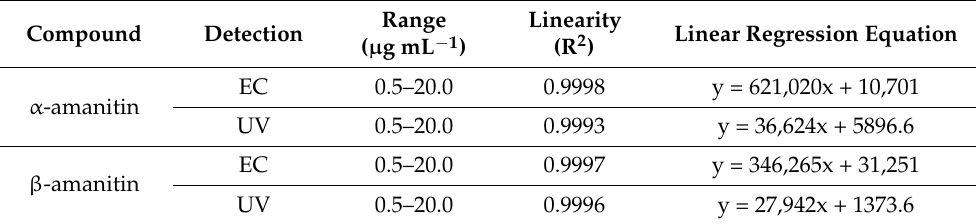
Table 1. Calibration curve parameters of α - and β -amanitin; regression equation and coefficient (R 2 ) are expressed as the mean of 4 calibration curves (n = 4).